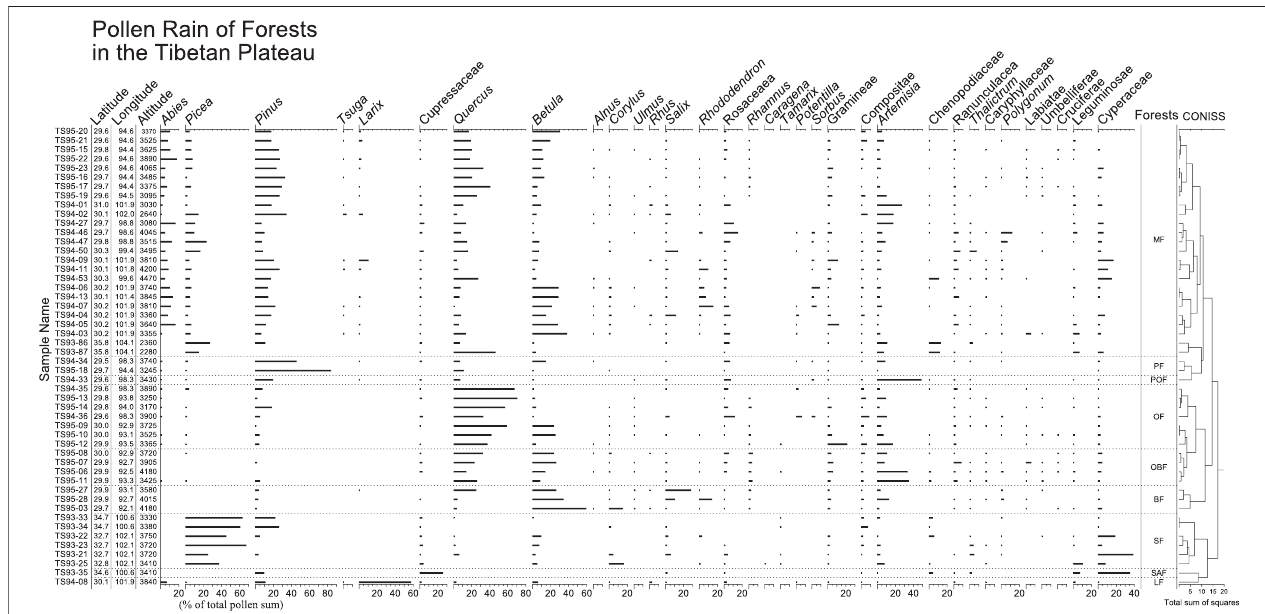
FIGURE3| Pollen percentage diagram forsurfacesamplesfromforestsinthe TibetanPlateau. Forest typesare: subalpinemixedforest (MF), pine forest (PF),pine and oak forest (POF), oak forest (OF), oak and birch forest (OBF), birch forest (BF), spruce forest (SF), juniper forest (JF), and larch forest (LF).